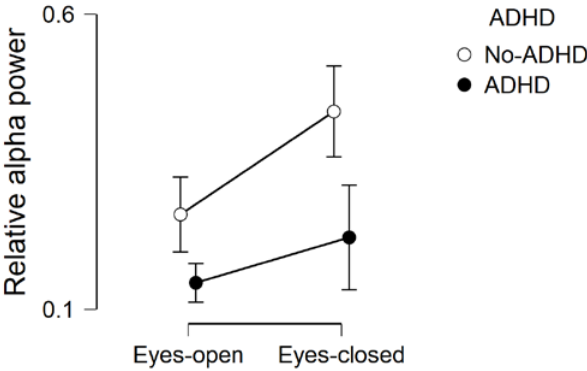
Figure 4. Comparison of relative alpha power during eyes-open and eyes-closed, across children with and without attention deficit hyperactivity disorder (ADHD). Error bars are 95% credible intervals.